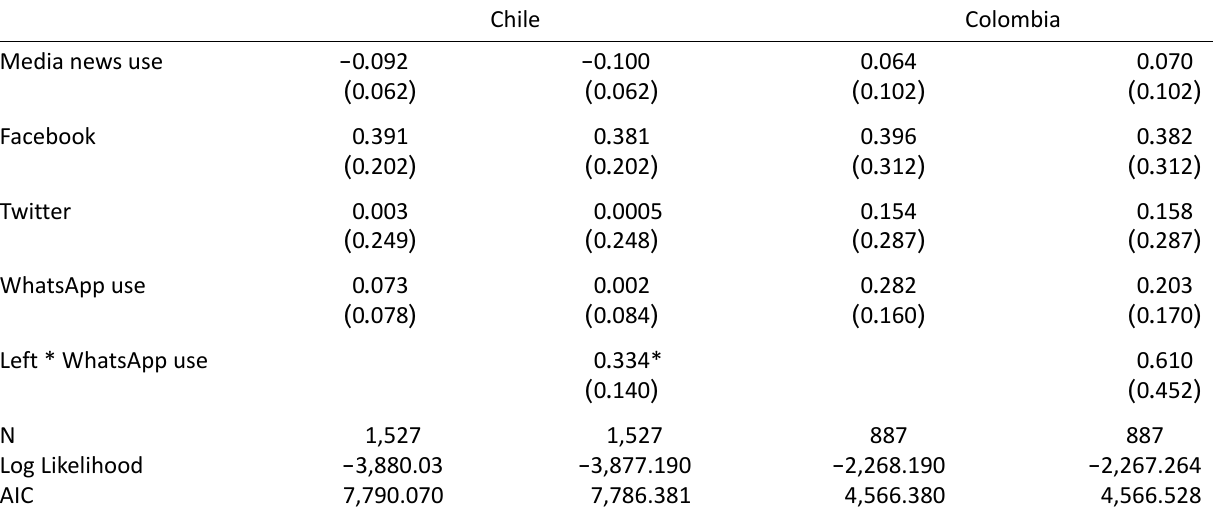
Table 3. (Cont.) Determinants of affective polarization.